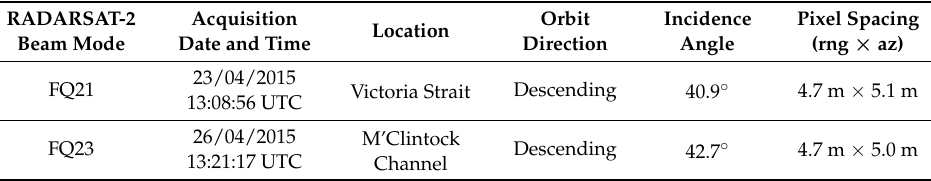
Table 1. Summary of Synthetic Aperture Radar (SAR) image